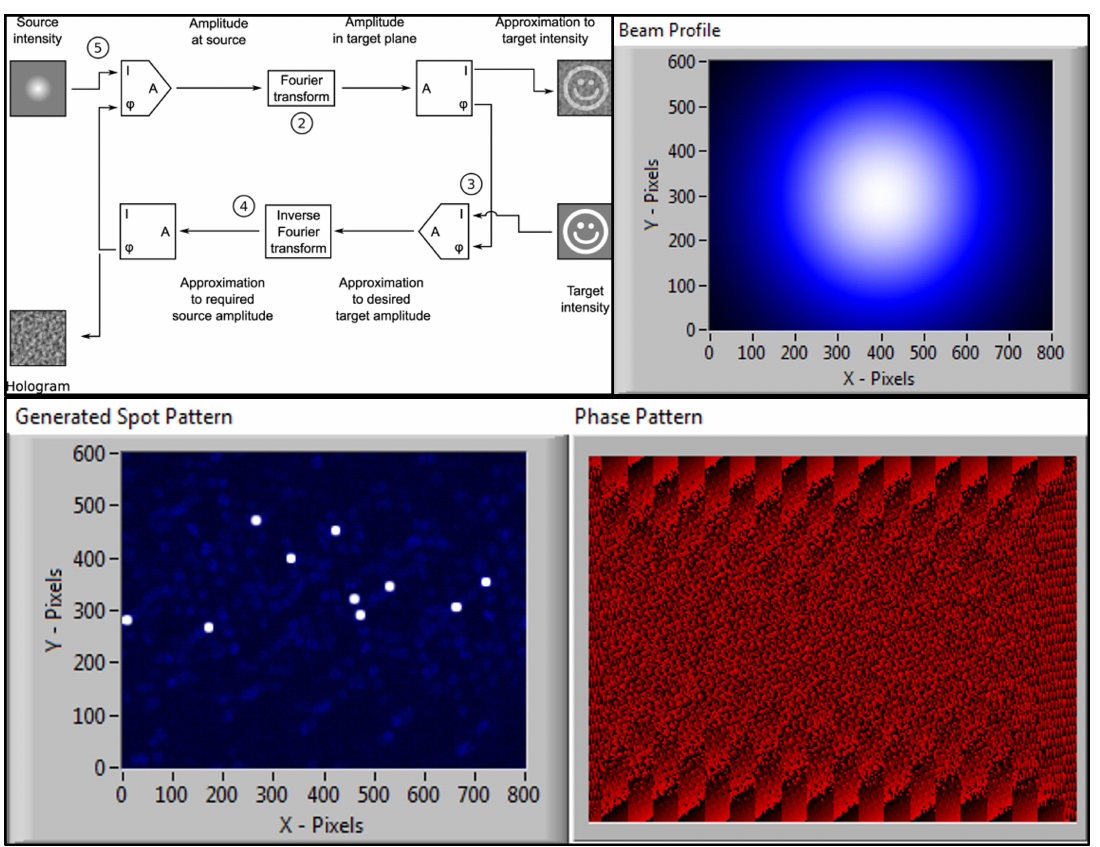
Figure 3. (a) Schematic representation of the Gerchberg Saxton algorithm. (b) SLM incident beam intensity profile. (c) Required SLM spot distribution. (d) The calculated phase modulation pattern. (Campbell,